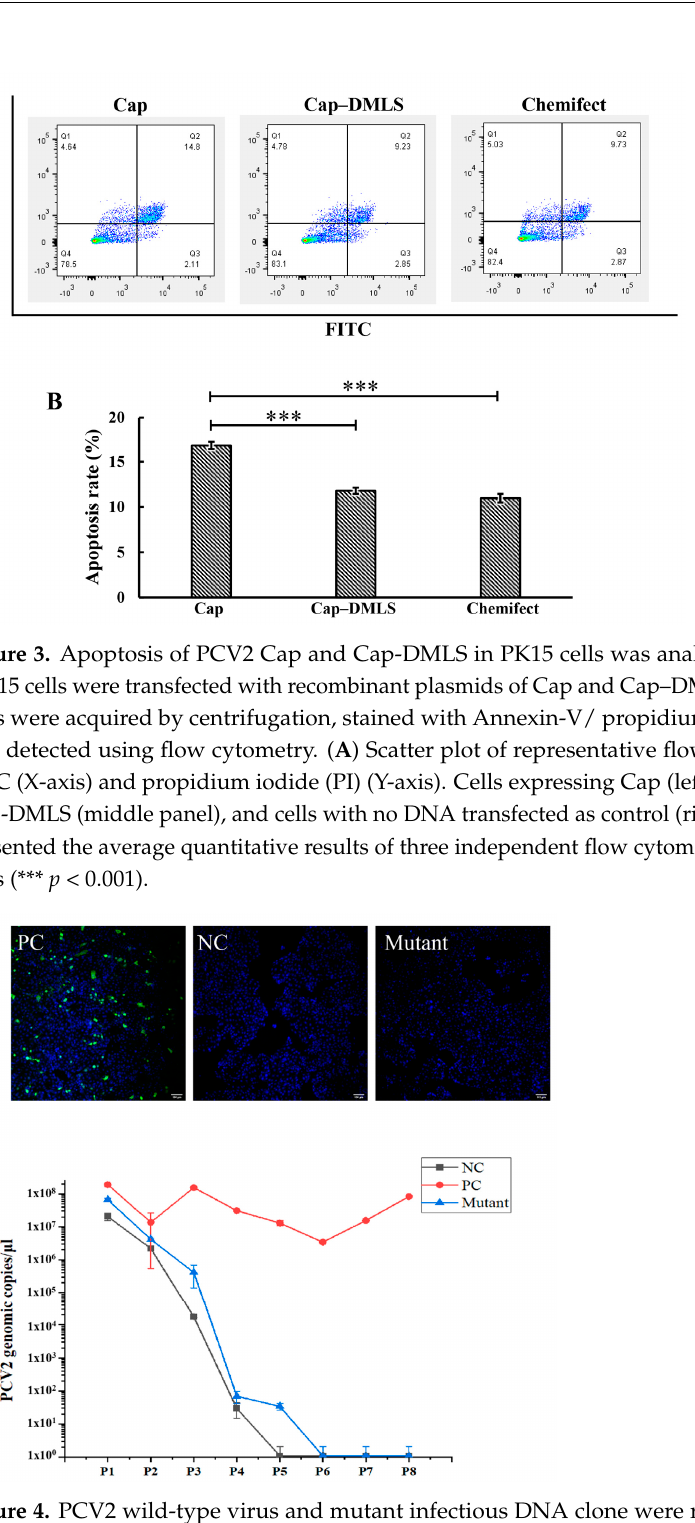
Figure 4. PCV2 wild ‐ type virus and mutant infectious DNA clone were rescued. PK15 cells were transfected with various PCV2 infectious clone DNA (WT and DMLS mutant), and then the cells grew for more than 8 passages. ( A ) The confocal images of PK15 cells transfected with various PCV2 infectious clone DNA of WT (positive control, PC) and mutant, and immunofluorescence staining of PCV2 Cap. The infectious clone DNA containing only one copy of stem loop was trans ‐ fected as negative control (NC). Green signal indicated the Cap and blue signal indicated the nucleus. Scale bar: 100 μ m. ( B ) PCV2 genomic copies in each passage were detected by quantitative real ‐ time PCR. The horizontal axis represented the numbers of cell passages, whereas the vertical axis represented the viral genomic copies. The results of three inde ‐ pendent experiments were used to